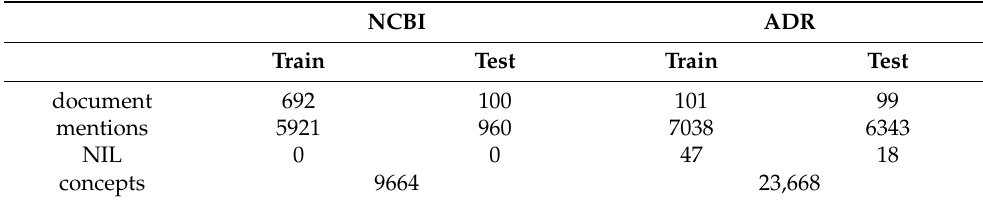
Table 1. Statistics of the two types of datasets. NCBI